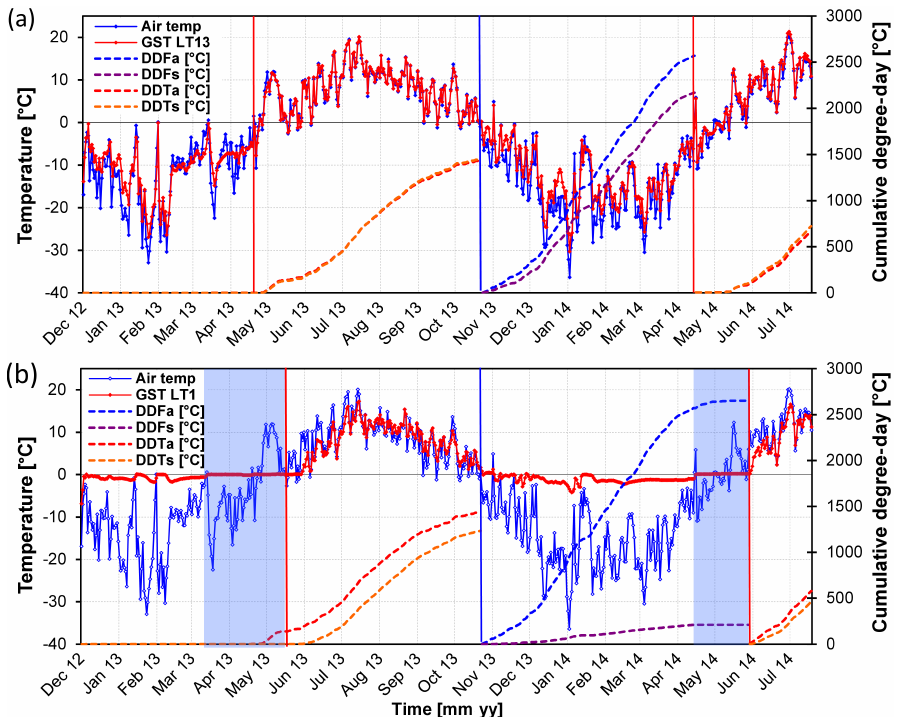
Figure 9. Evolution of the ground surface temperature (GST) from December 2012 to August 2014 for the sensors LT13 (a) and LT1 (b) , which are representative of the thermal regime of the sensors on the zone with a thin snowpack and areas with a thick snowpack respectively. The dashed lines represent the cumulative freezing degree day (DDF) and thawing degree day (DDT) at the ground surface and in the air. The red vertical lines mark the end of the freezing season while the blue lines mark the beginning. Finally, the blue zones represent the duration of the zero curtain effect